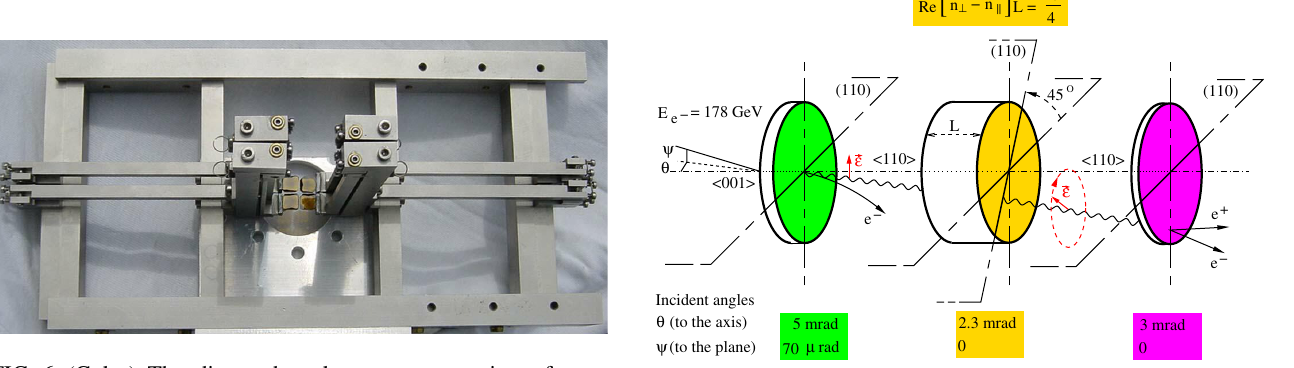
FIG. 7. (Color) Three crystal